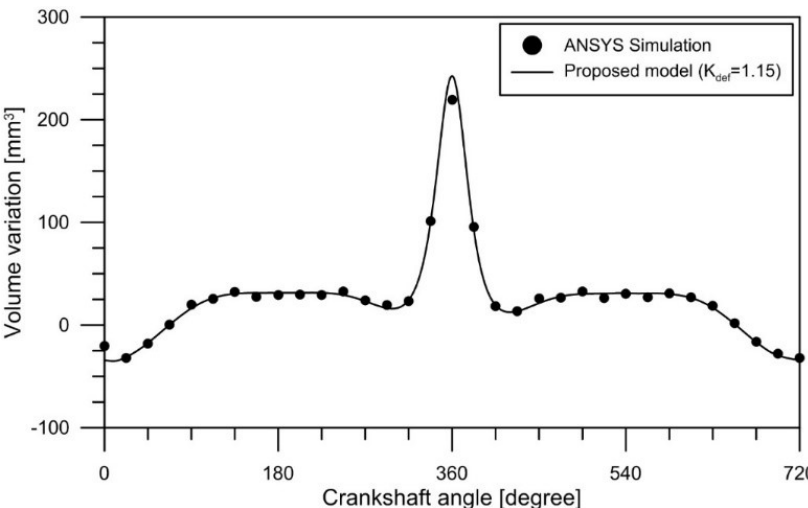
Figure 12. Results of ANSYS ® and the adjusted model, at 3500 rpm.